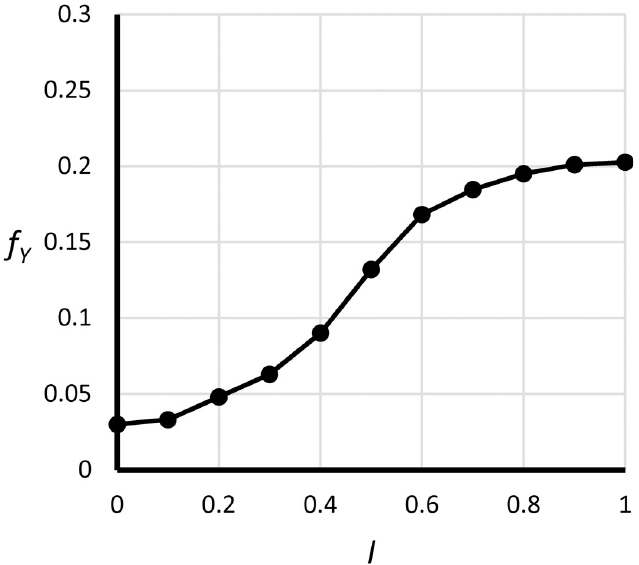
Fig 22. Graphical function f y ( I ).